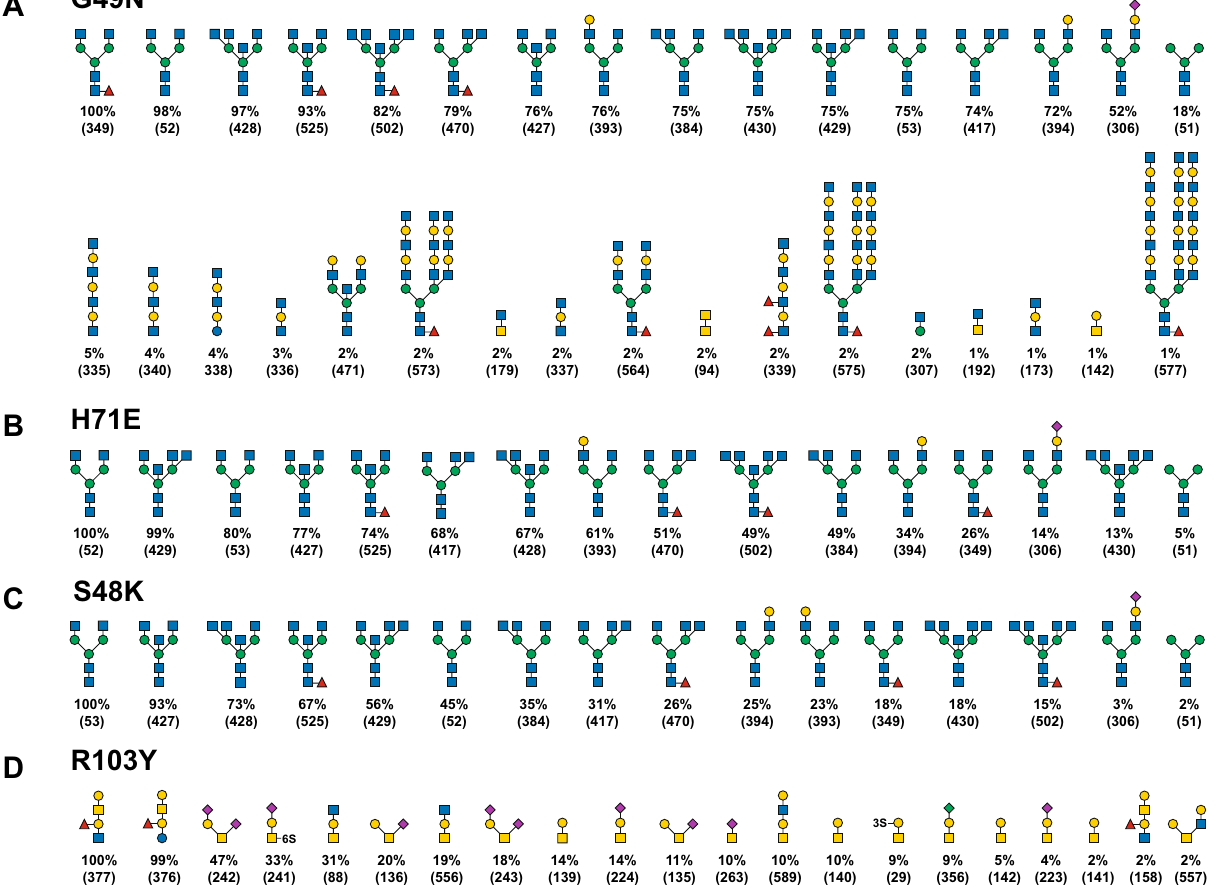
Figure 4. Oligosaccharide binding specificity of BGL mutant proteins using a mammalian glycan array. Fluorescently labeled proteins G49N, H71E, S48K, and R103Y were used to probe a mammalian glycan array at the Consortium for Functional Glycomics. ( A – D ) The specificity of each mutant was determined by testing its ability to bind to a printed array (version 5.3) consisting of 600 mammalian glycans. The structures of oligosaccharides bound by each protein are shown in decreasing order of ligand binding efficiency down to 1% binding relative to the strongest signal (see Supplementary Tables 3–6 for raw array data). Structures appearing more than once reflect identical glycans in the array that possess different chemical linkers. The CFG array’s Glycan ID numbers for each structure are shown in parentheses. Sugar symbols are as shown in Fig.